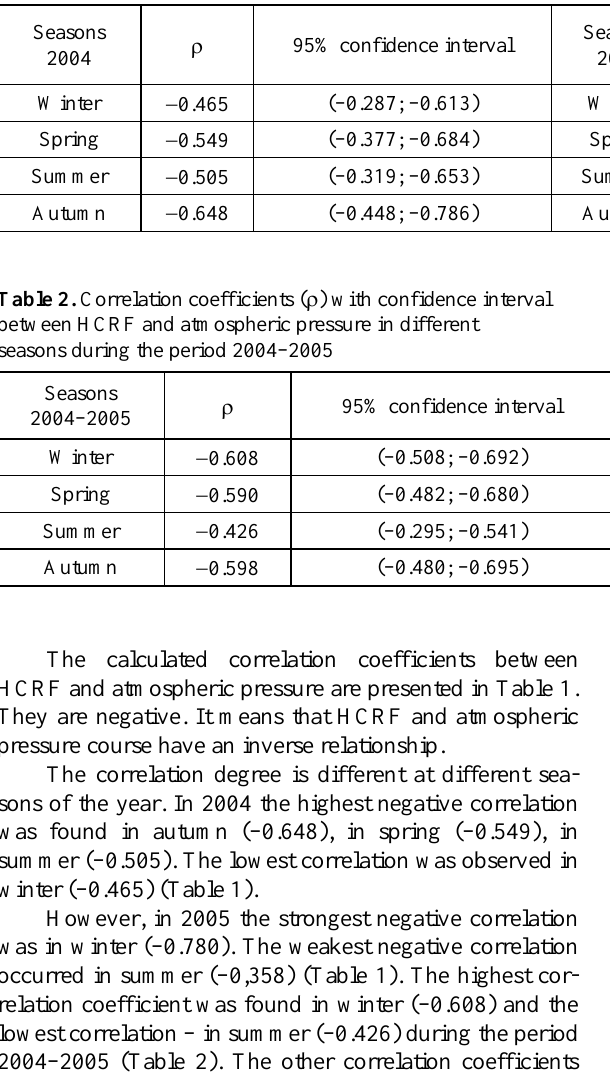
Table 1. Correlation coefficients ( ρ ) with confidence interval between HCRF and atmospheric pressure in different seasons in 2004 and 2005